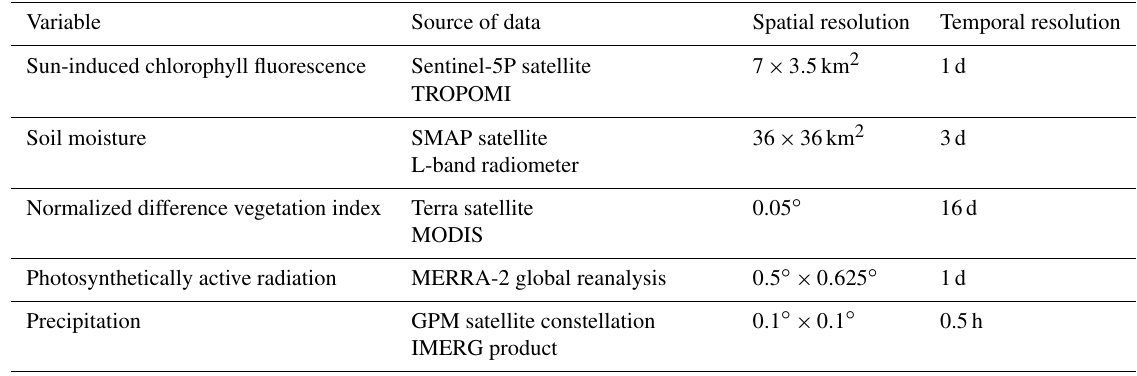
Table 1. List of datasets used in this study with their respective native spatial and temporal resolution. Note that the datasets were all linearly aggregated to a spatial resolution of 72 × 72km 2 and 8d periods.